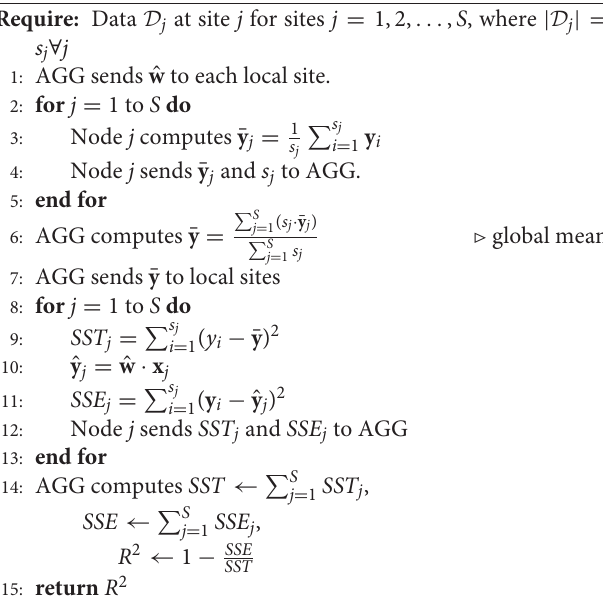
Algorithm 4 Decentralized R 2 calculation